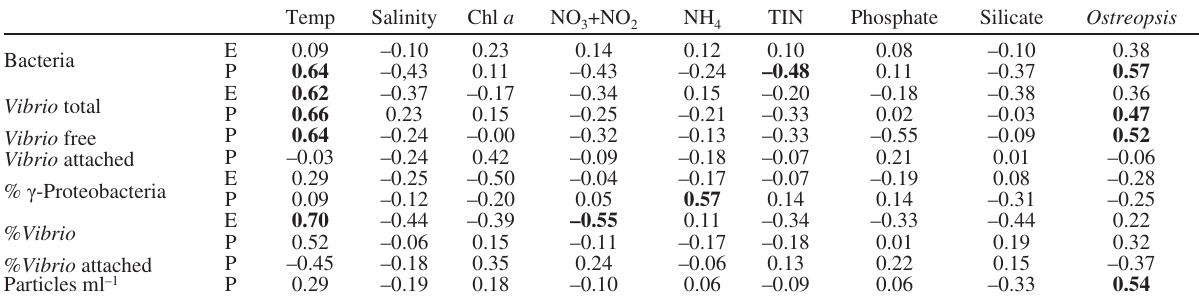
Table 1. – Pearson correlation coefficients between epiphytic (E) and planktonic (P) concentration of bacteria, vibrios and particles and selected abiotic and biotic variables at Sant Andreu de Llavaneres in 2010; n=13-17. Significant correlations (p<0.05) are indicated in bold. TIN, total inorganic nitrogen Temp Salinity TIN Phosphate Silicate Ostreopsis Bacteria Vibrio